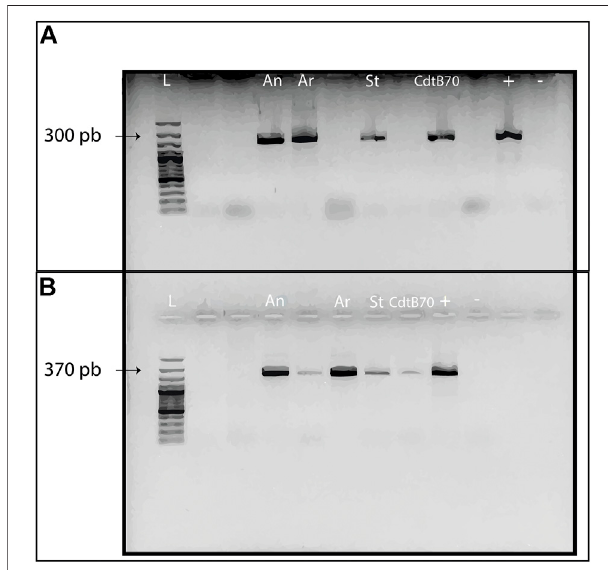
FIGURE 5 | PCR ampli fi cations of genes implied in Cd immobilization throughthebioweatheringpathway. (A) . CadA ampliconsfromcompositesoil samples. (B) . smt amplicons from the assessed soil samples. Conventions: L = Ladder; CdtB70 = CdtB strain from Santander, Colombia; + = Positive control strain Cupriavidus taiwanensis DSM17343; - = Negative control, ultra-nanopure sterile H 2 O with dimer-primers.